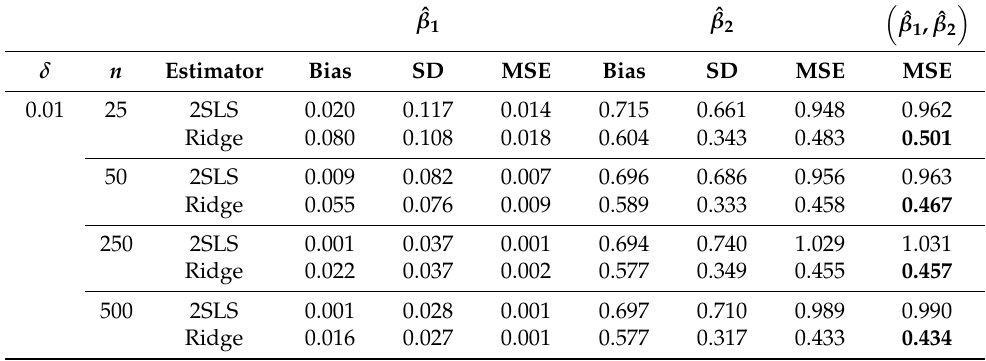
Table A2. The simulated model is given by Equations (1), (2), (4) and (12) with k = 2, m = 4, z i ∼ iid N ( 0, I 4 ) , and β 0 = ( 0,0 ) (cid:48) . Summary statistics are reported for estimates of ˆ β 1 and ˆ β 2 using ) (cid:48) , where τ = 0.5. The models differ with respect to the 2SLS and ridge estimator for β p = ( 1 , 1 2 2 strength of the instrument ( δ ) and sample size ( n ). Each model is simulated 10,000 times. The ridge estimator outperforms the 2SLS estimator in terms of MSE values in a number of cases. In particular, in small samples and low precision settings, the ridge estimator leads to smaller MSE